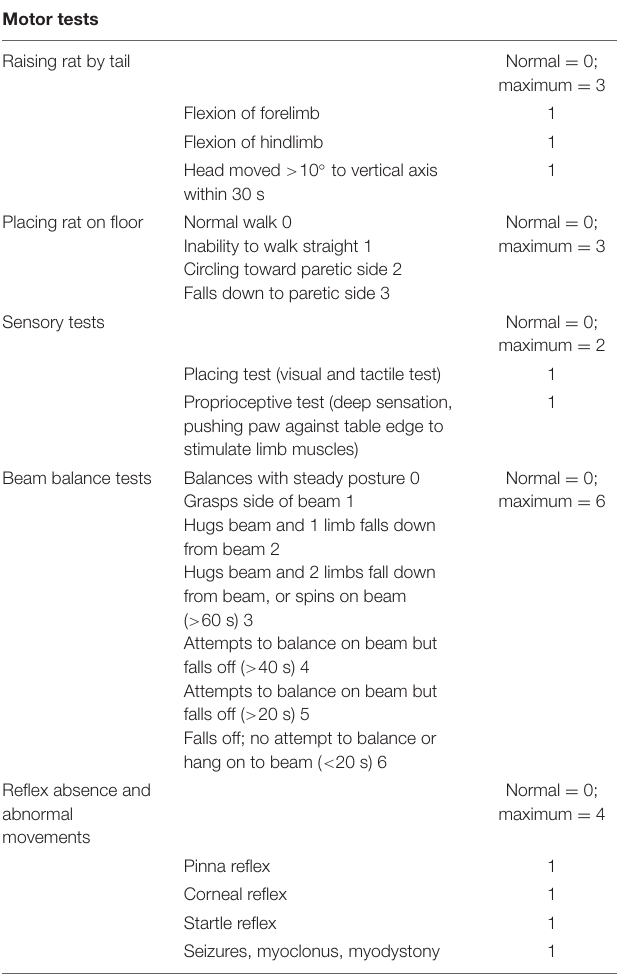
TABLE 1 | Components of the modified neurological severity score (mNSS) and scoring